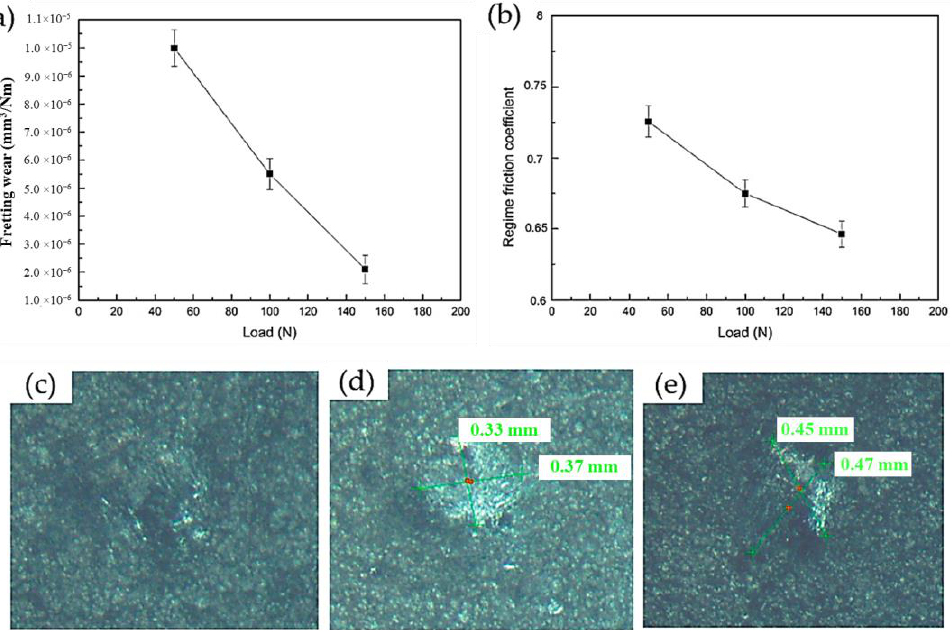
Figure 18. The ( a ) fretting wear; ( b ) COF; and OM of the wear tracks of CS IN625 deposit under ( c ) 50 N, ( d ) 100 N, and ( e ) 150 N loadings. Reprinted from Cavaliere et al., Copyright 2021 [116], under CC BY 4.0.